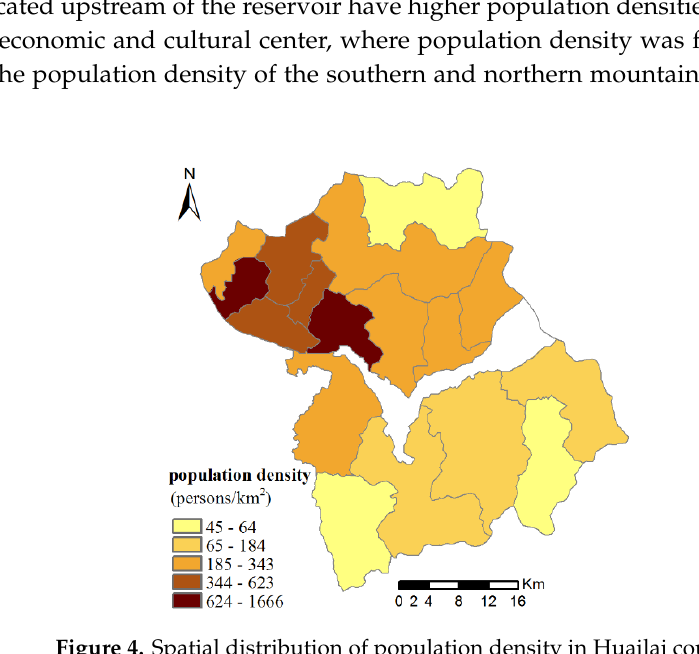
Figure 4. Spatial distribution of population density in Huailai county.